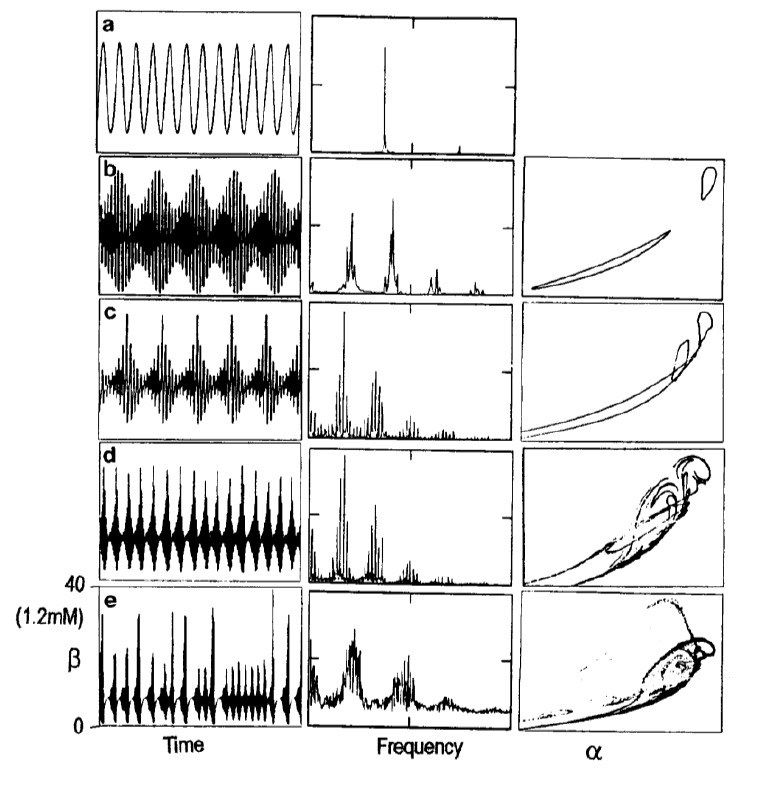
Figure 6. Quasiperiodicity route to chaos under constant substrate input flux. Evolution of ( a ) periodic oscillation, ( b – c ) quasiperiodic motion, ( d ) complex quasiperiodic oscillations and ( e ) chaotic responses. (The  concentrations are represented as a function of time). Also shown are the corresponding power spectra (second column) and Poincaré sections (  ,  plane). Reproduced with permission from ScienceDirect